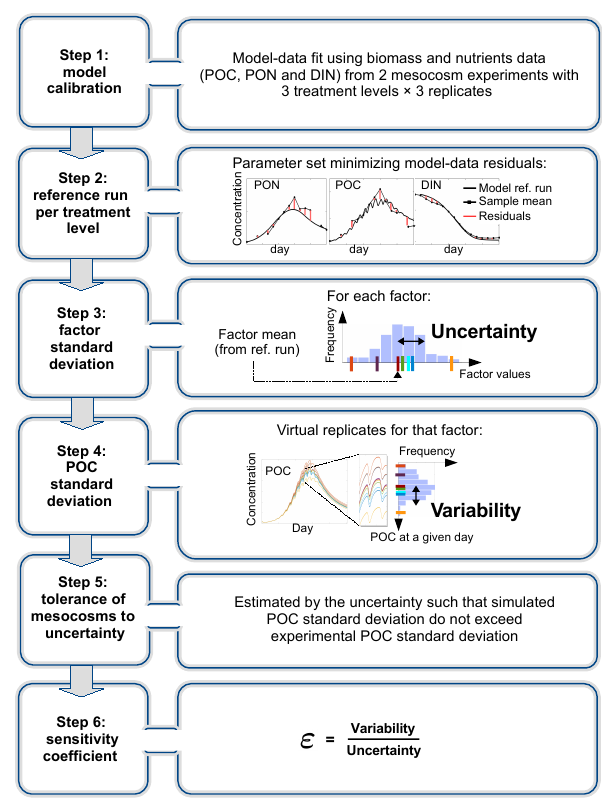
Figure 1. Variability decomposition method based on uncertainty propagation (summary of the basic principles given in Sect. 5.1.1 and 5.6.2. and Annex B in JCGM,